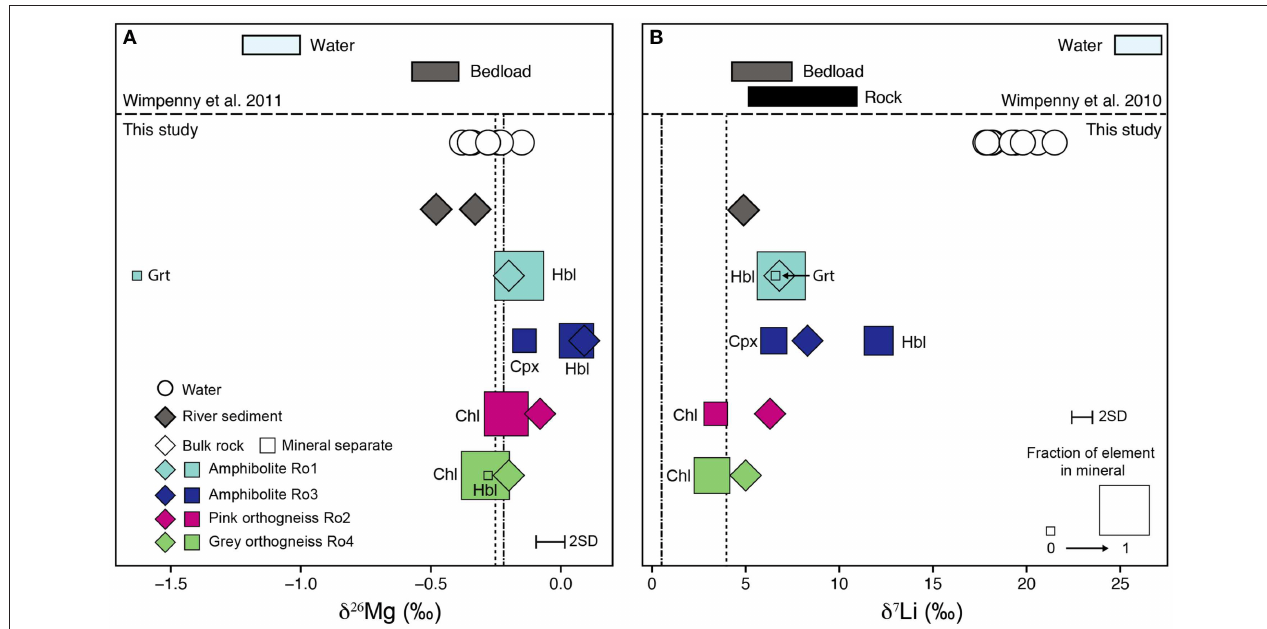
FIGURE 3 | Range of magnesium (A) and lithium (B) isotope values measured in the rocks, mineral separates, and river water of the Leverett Glacier catchment. Mineral abbreviations are: Grt, garnet; Hbl, hornblende; Chl, chlorite; Cpx, clinopyroxene. The fraction of the element contained in each mineral ( Table 1 ) is indicated by the size of the square. Also shown are data from Wimpenny et al. (2010, 2011) which were collected in the same region, but not the same outlet glacier ( Figure 1 ). The vertical dotted lines depict the normal mantle value for Mg (–0.25 h , Teng et al., 2010) and the upper mantle value for Li ( + 4 h , Teng et al., 2004). The dash-dot lines indicate average upper continental crust values for Mg (–0.22 h , Li et al., 2010) and Li ( + 0.6 h , Sauzéat et al.,